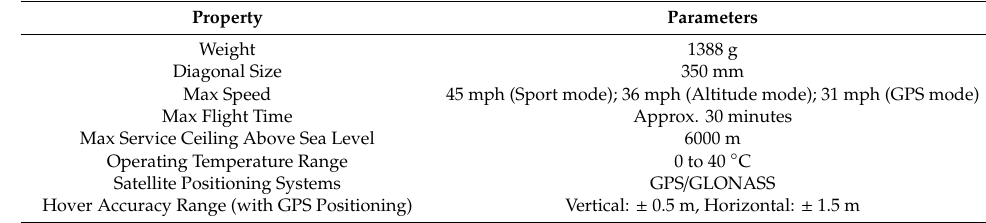
Table 1. Technical specifications of DJI Phantom 4 Pro Quadcopter.